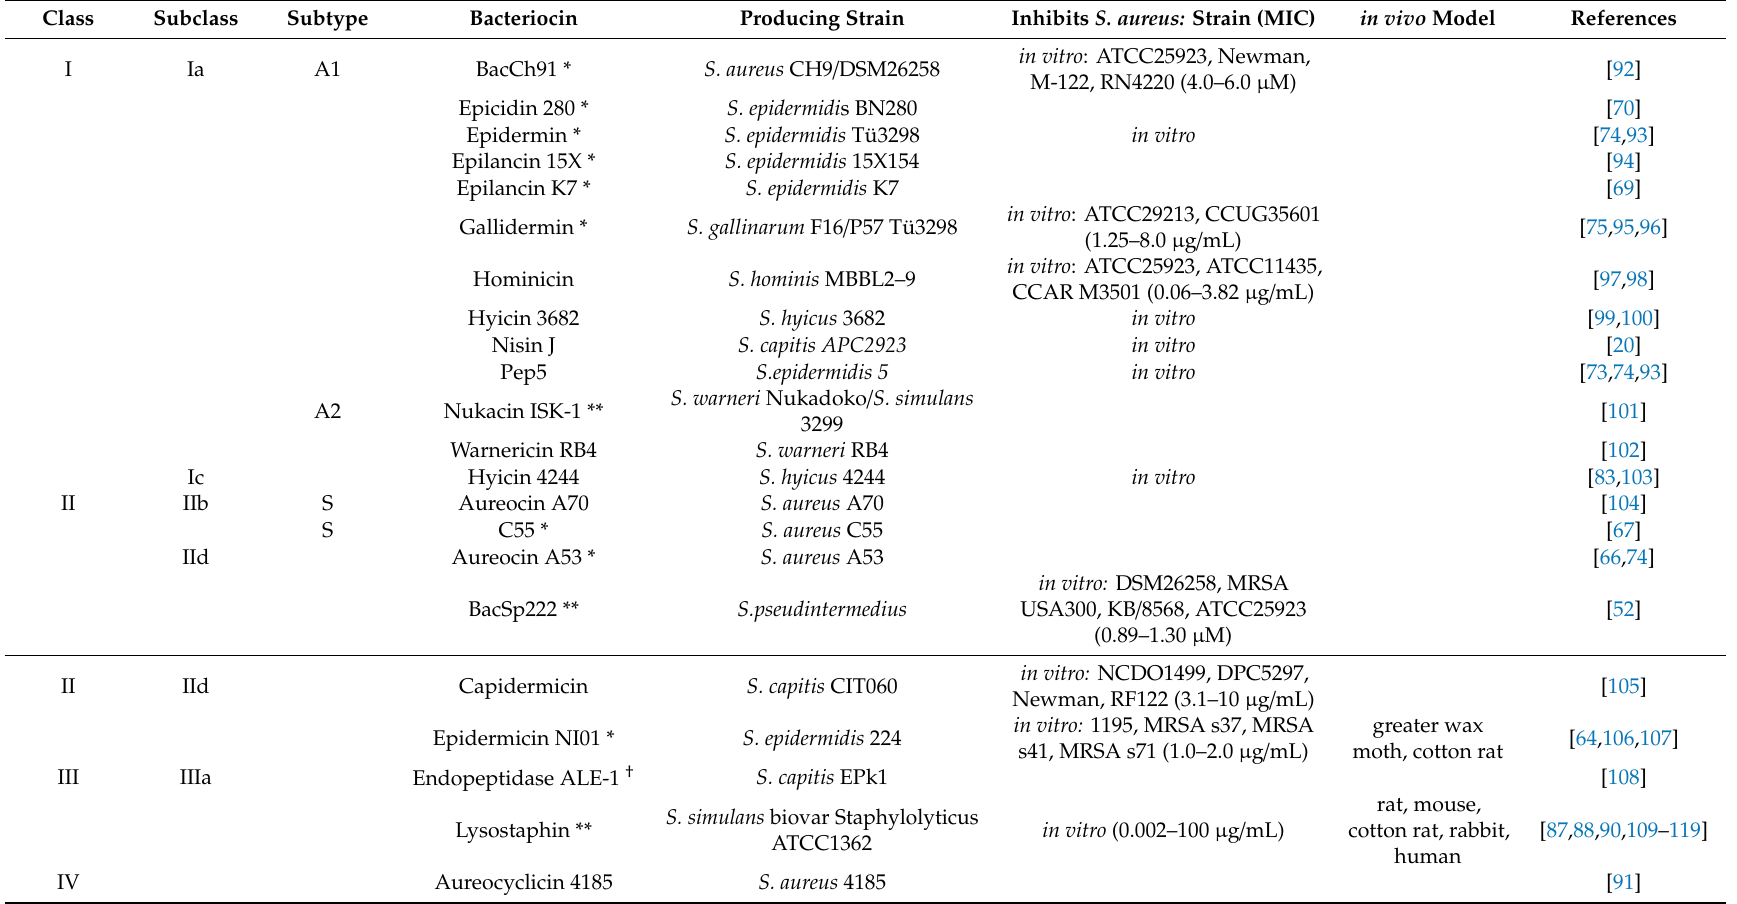
Table 1. Well-characterised bacteriocins isolated from Staphylococcus